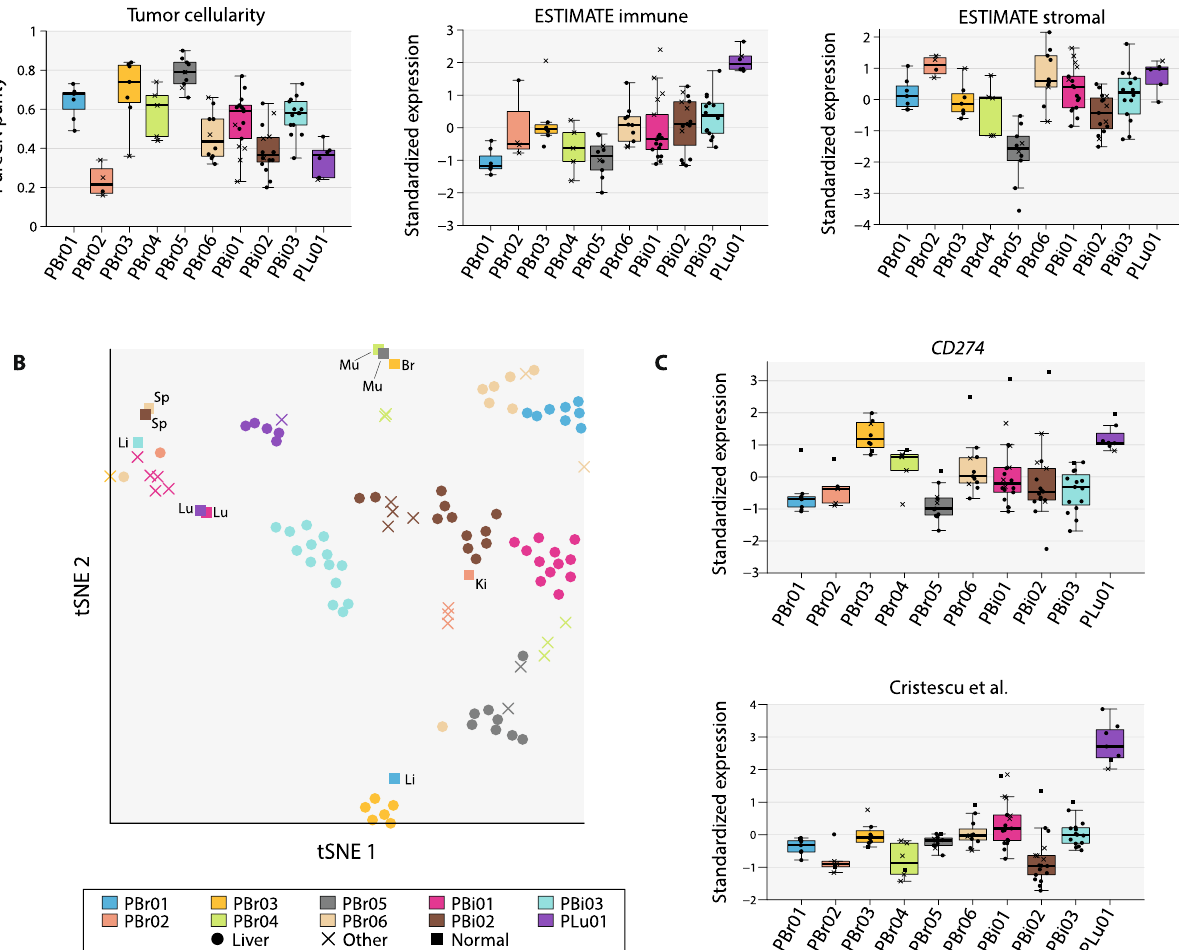
Fig. 3 Spatial heterogeneity in the tumor microenvironment. A Tumor cellularity estimates (from PureCN) and measurements of overall immune and stromal signatures (from ESTIMATE) are shown for all lesions from each patient. Immune and stromal signature scores were transformed into z -scores across all samples and point shapes are used to differentiate between liver and non-liver lesions (circle = liver, cross = non-liver). The boxplots represent the distributions of each variable. For each patient, the boxplot ’ s whiskers span the minimum and maximum of the distribution, the box spans the lower and upper quantiles, and the center represents the median value of the distribution. B Single-sample GSEA was used to score a set of TME-related gene expression signatures and t -SNE was performed, using the resulting scores matrix to cluster samples by their overall TME pro fi les. Samples clustering together in the t -SNE plot suggest similarities in TME composition across the dataset. As depicted in the legend, point symbols are used to differentiate between metastases in the liver, metastases in other organs, and histologically normal samples. Anatomic sites of the normal lesions are also annotated (Ki kidney, Br breast, Lu lung, Sp spleen, Li liver, Mu skeletal muscle). C Expression levels of CD274 and an ICI-predictive gene signature (Cristescu et al.) are shown. The y -axis indicates z -scores for each signature across all samples in the dataset. Point shapes are de fi ned in the legend. The boxplots depict the variable distributions as de fi ned in A . Source data are available for this fi